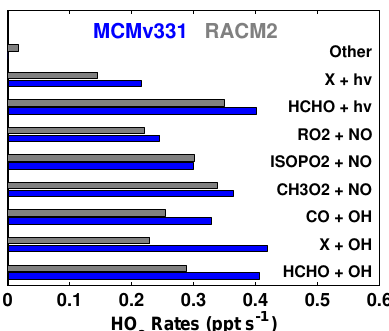
Figure 7. Comparison of HO 2 sources for the MCMv331 (blue) and RACM2 (gray) steady-state simulations. Production rates are instantaneous values from the model step at UTC hour 16.2 (see Fig. 6). In the labels, “X” and “RO2” refer to all HO 2 -producing species other than those listed